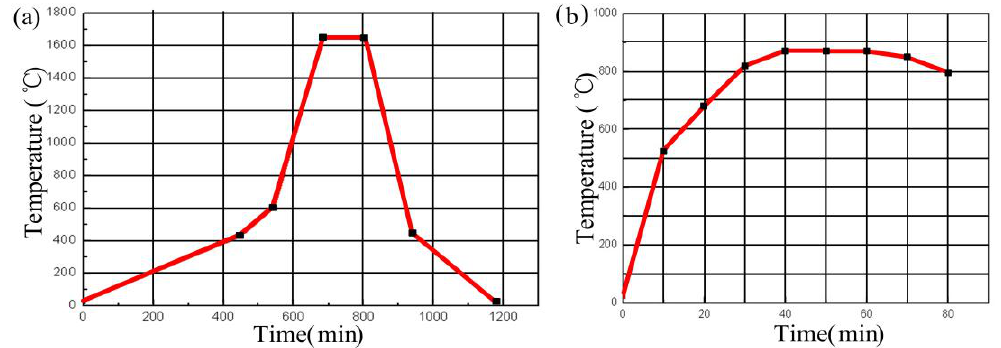
Figure 5. Sintering curve for the curing process of ( a ) the alumina ceramic substrates and ( b ) the electrical elements.